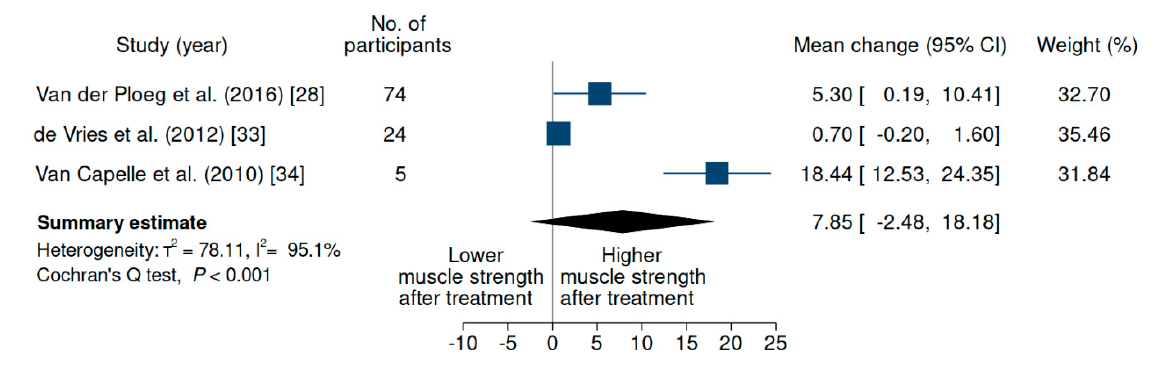
Figure 5. Evaluation of the Quick Motor Function Test in patients with late-onset Pompe disease on enzyme replacement therapy with alglucosidase alfa. Weights are inverse-variance weights and are proportional to the contribution of each study to the summary estimate. I² is the fraction of variance that is due to statistical heterogeneity and not chance. Tau² denotes the between-study variance